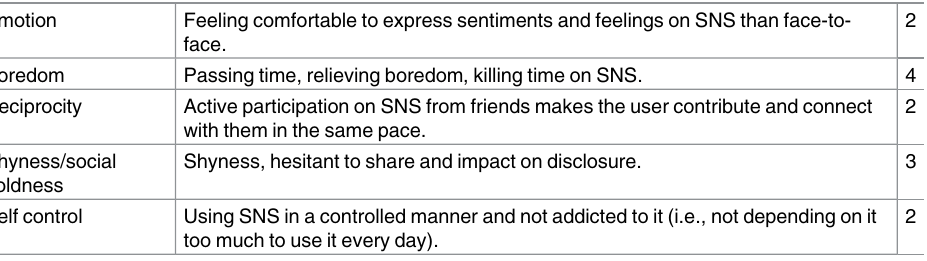
Table 10. SNS user behavior characteristics identified.